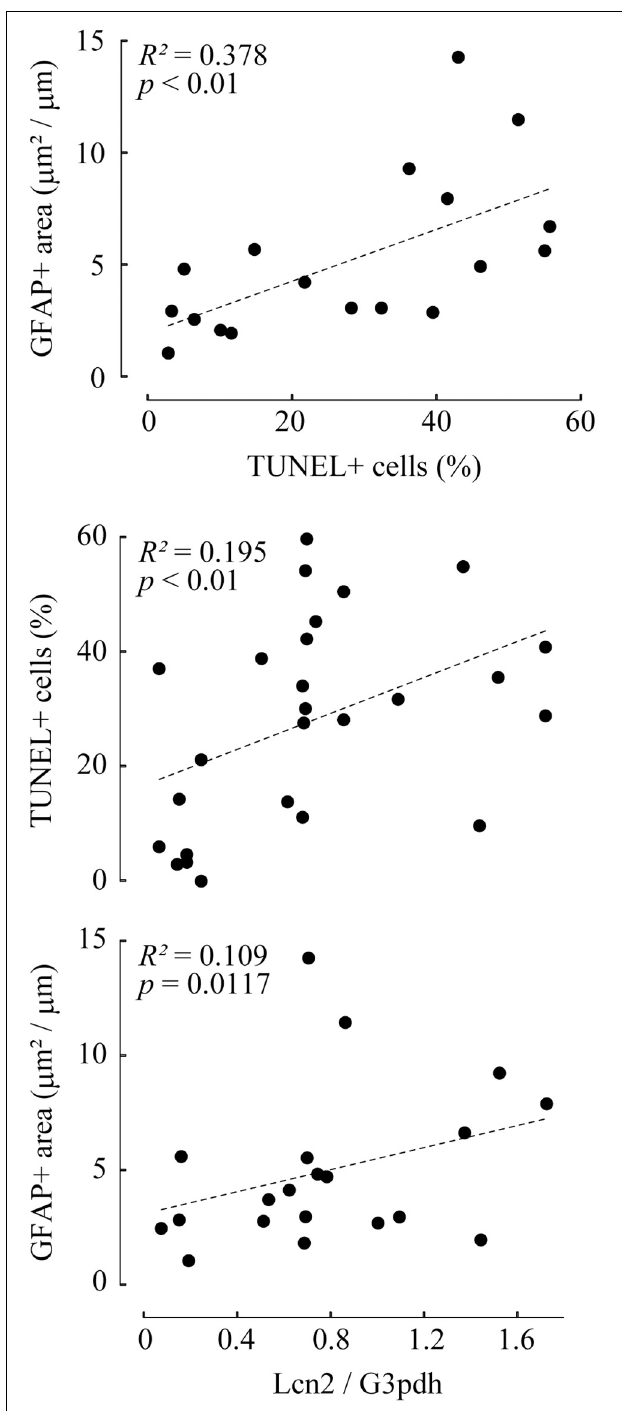
FIGURE 4 | Correlation analyses between TUNEL-positive cells, GFAP-positive area, and lipocalin 2 (Lcn2) protein level. The values of TUNEL-positive cells and GFAP-positive area are represented as a scatter plot (top). The values of Lcn2 protein levels with TUNEL-positive cells (middle) or GFAP-positive area (bottom) are shown in the scatter plot. In each graph, the dot distribution approximates a linear function (dotted lines). Correlations and statistical significance were analyzed using Spearman’s rank test. R 2 - and p -values are